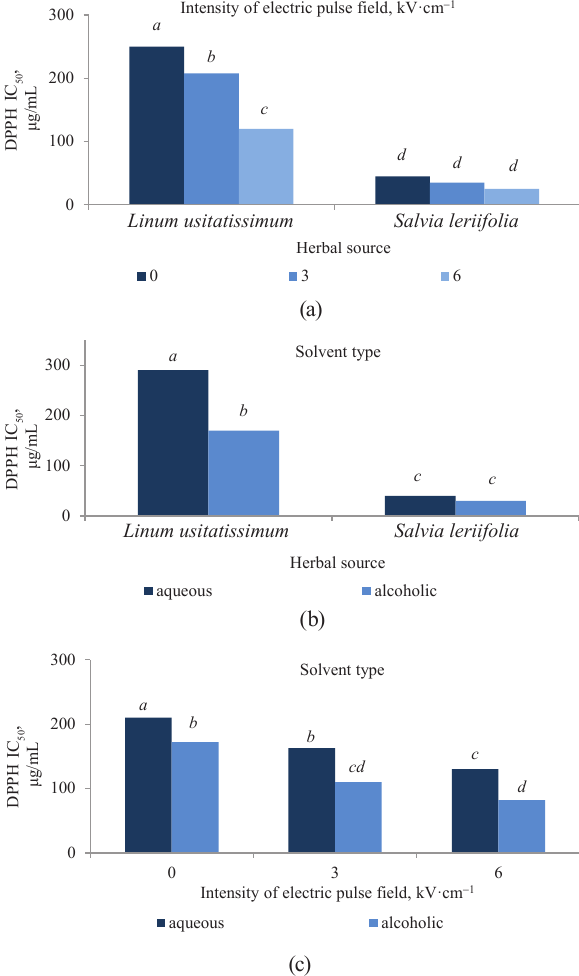
Figure 4 Binary effects of herbal source and pre-treatment (a), herbal source and solvent type (b), and pre-treatment and solvent type (c) on antioxidant activity by DPPH method ( P ˂ 0.05)